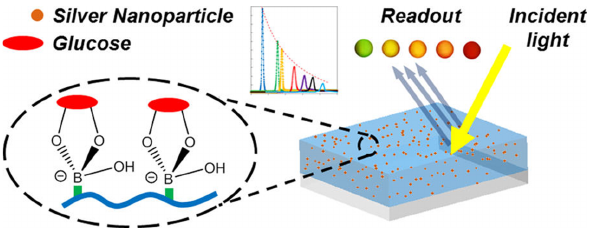
Figure 20: Illustration of the sensor for sensing the target glucose. Reprinted with permission from [74]. Copyright 2014, American Chemical Society